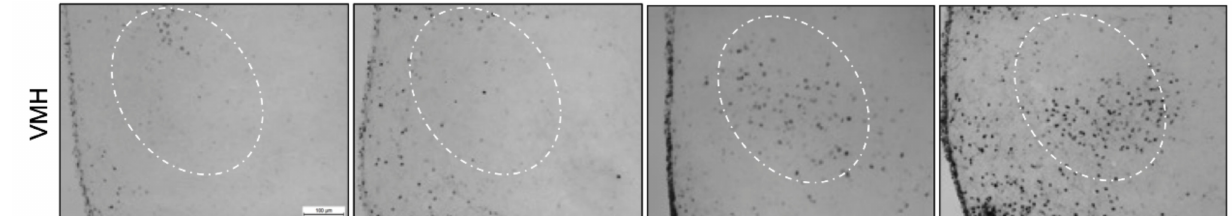
Figure 4. Effect of prolonged icv infusion of vehicle or HU308 for 2 weeks on the number of pSTAT3+ cells in the paraventricular (PVN), arcuate (ARC) and ventromedial (VMH) nuclei in animals fed a control diet or high-fat diet (HFD). Number of pSTAT3+ cells in the PVN ( A ), ARC ( B ) and VMH ( C ) nuclei in animals fed a control diet or HFD that received icv injection of vehicle (white bars) or HU308 (dark grey bars). The data are expressed as the mean ± SEM, n = 5–6 per group. One sample from control diet + HU308 group were missed during the pSTAT3 immunostaining protocol. Data were analyzed by two-way ANOVA followed by Tukey’s post-hoc test. @ p < 0.05 (effect of diet) Bottom panel: Representative photomicrographs of pSTAT3 immunostaining in the PVN (superior panel), ARC (central panel) and VMH (inferior panel) of control diet-fed or HFD-fed animals treated with vehicle or HU308.